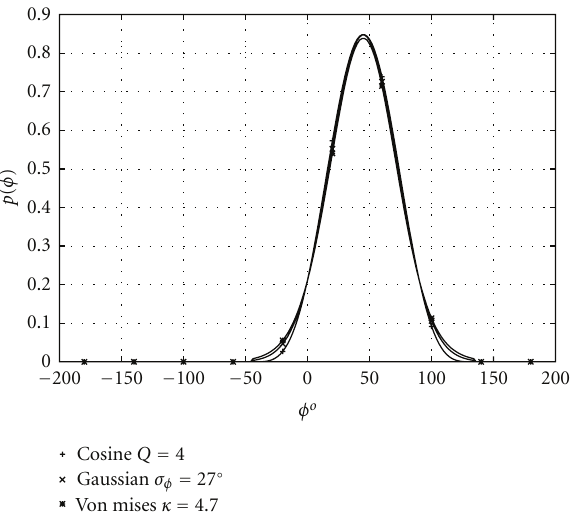
Figure 2: Probability density functions of Von Mises, Gaussian, and cosine for Q = 4, σ φ = 27 ◦ , κ = 4 .